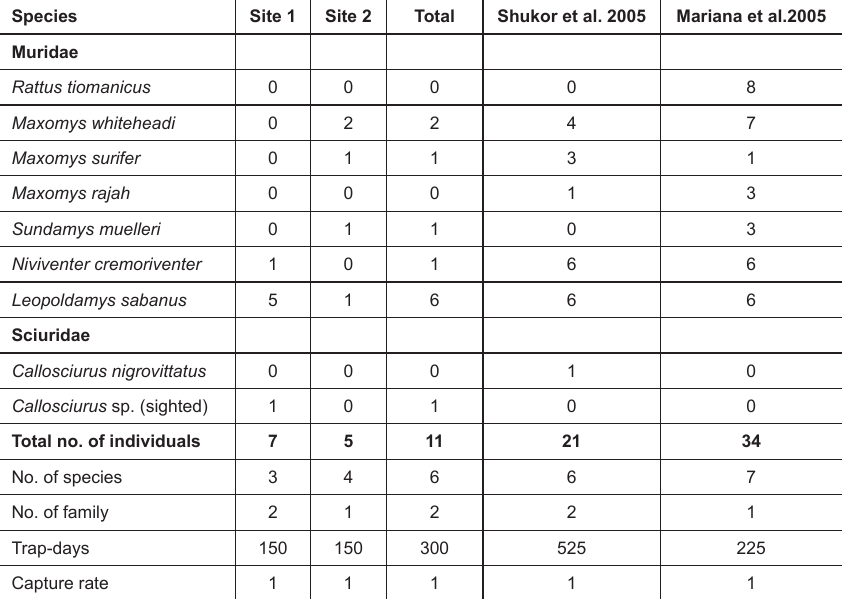
Table 2. List of species caught, net nights and capture rate of non-volant small mammals in this study